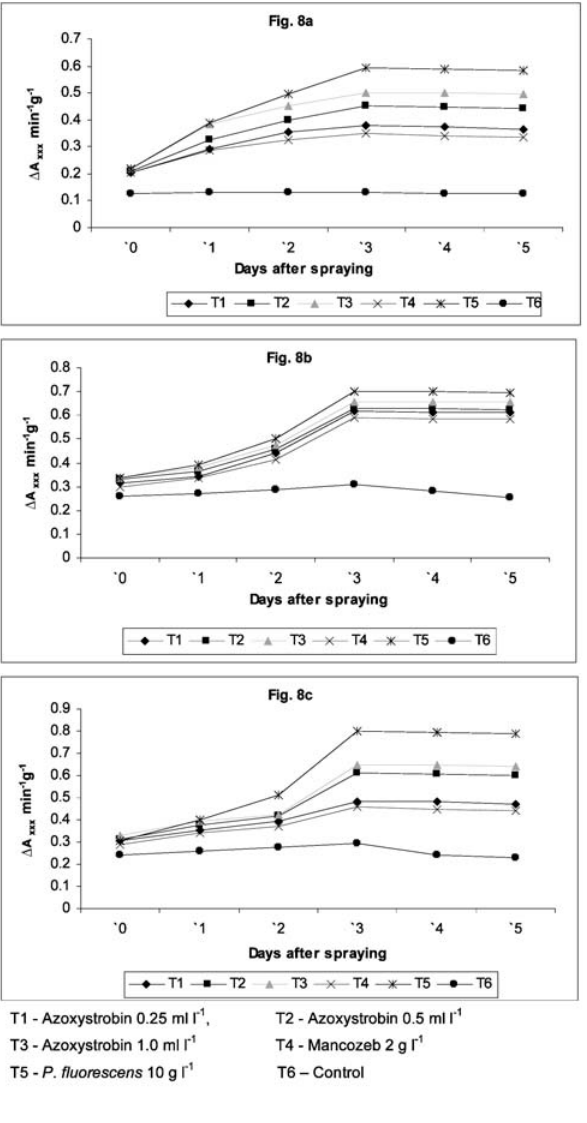
Fig. 9. Changes in total phenols in cucumber plants: 9a, uninoculated and treated with azoxystrobin and Pseu- domonas fl uorescens ; 9b, challenge-inoculation of downy mildew pathogen; 9c, challenge-inoculation of powdery mildew